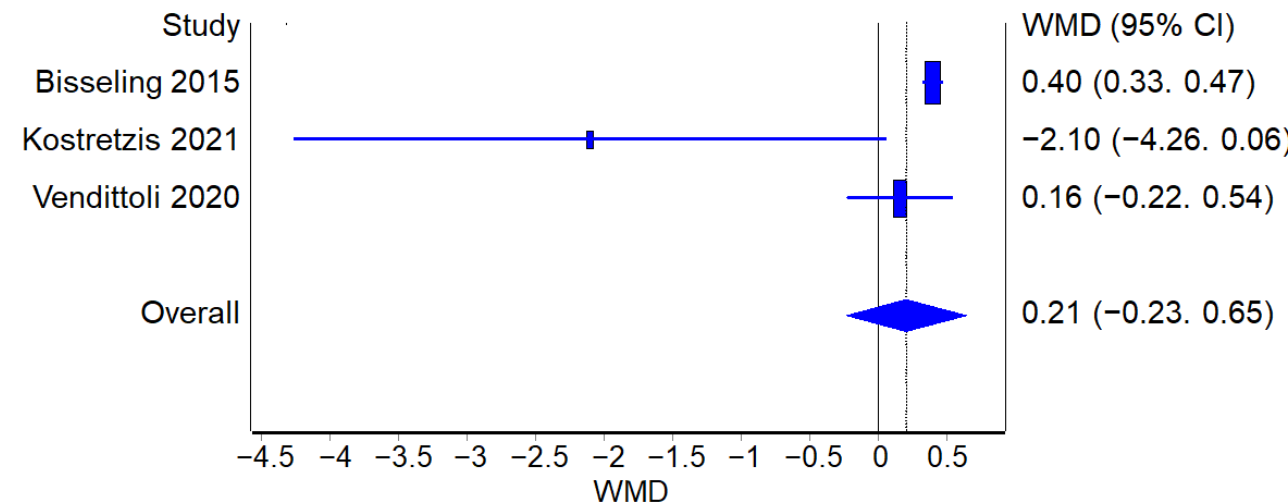
Figure 11. Cobalt Levels: Forest plot of the individual studies and pooled mean difference for blood cobalt levels, including a 95% confidence interval. The size of the squares shows the weight of the study [17–19,21,27–31].